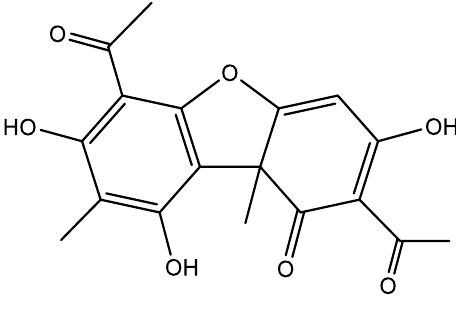
Figure 4. Chemical structure of usnic acid.